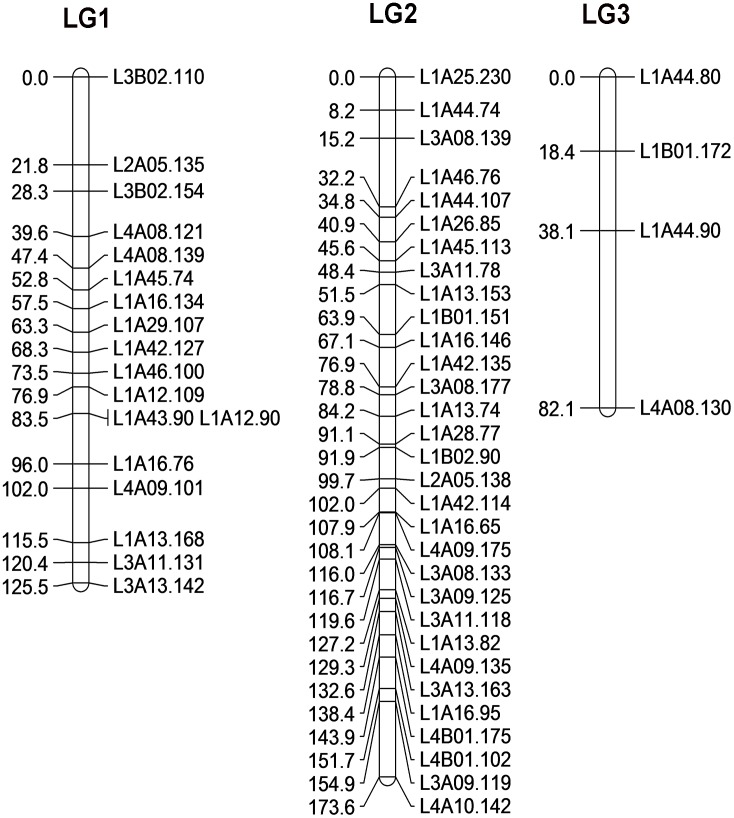
AFLP-based linkage map in Culex pipiens pallens.Three linkage groups are arranged at an LOD of 6.0 (p < 0.05). Numbers on the left side of each linkage group are genetic distances (cM) and AFLP markers are shown on the right.